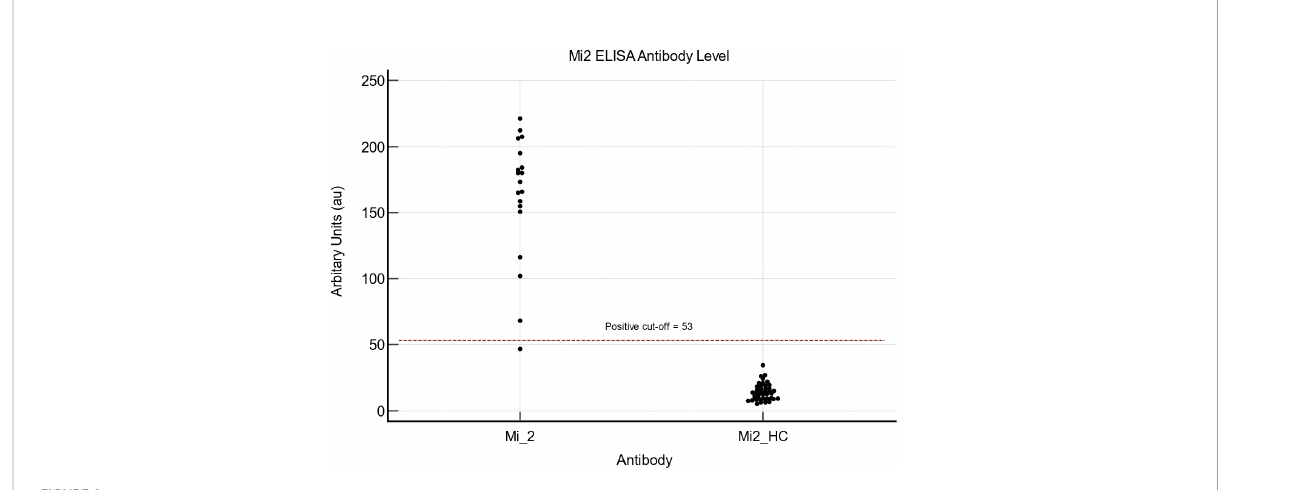
FIGURE 1 Mi2 ELISA values for 19 Mi2 and 63 healthy control